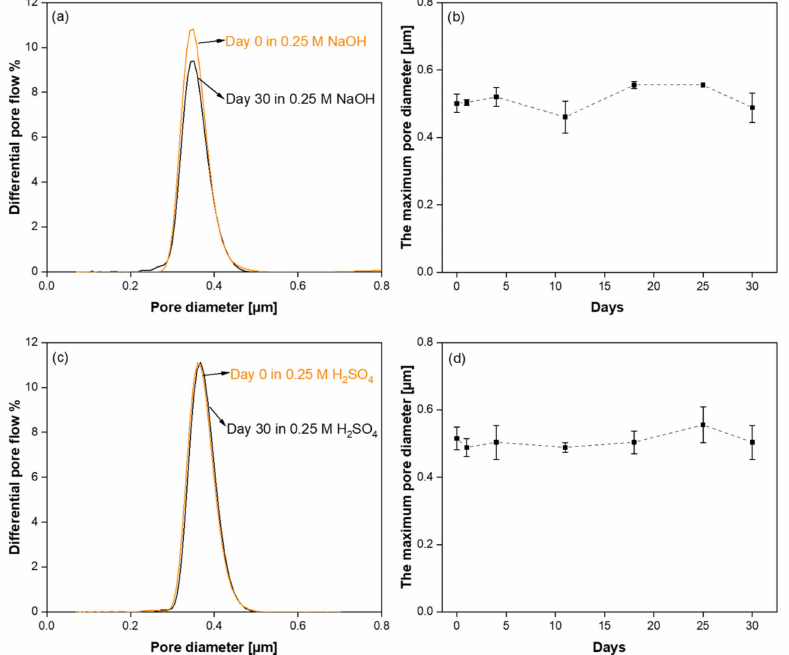
Figure 7. ( a ) Pore size distributions of final SiC membrane before and after alkali corrosion; ( b ) The change of the maximum pore size of SiC membrane exposed to alkali corrosion; ( c ) Pore size distributions of final SiC membrane before and after acid corrosion; and ( d ) The change of the maximum pore size of SiC membrane exposed to acid